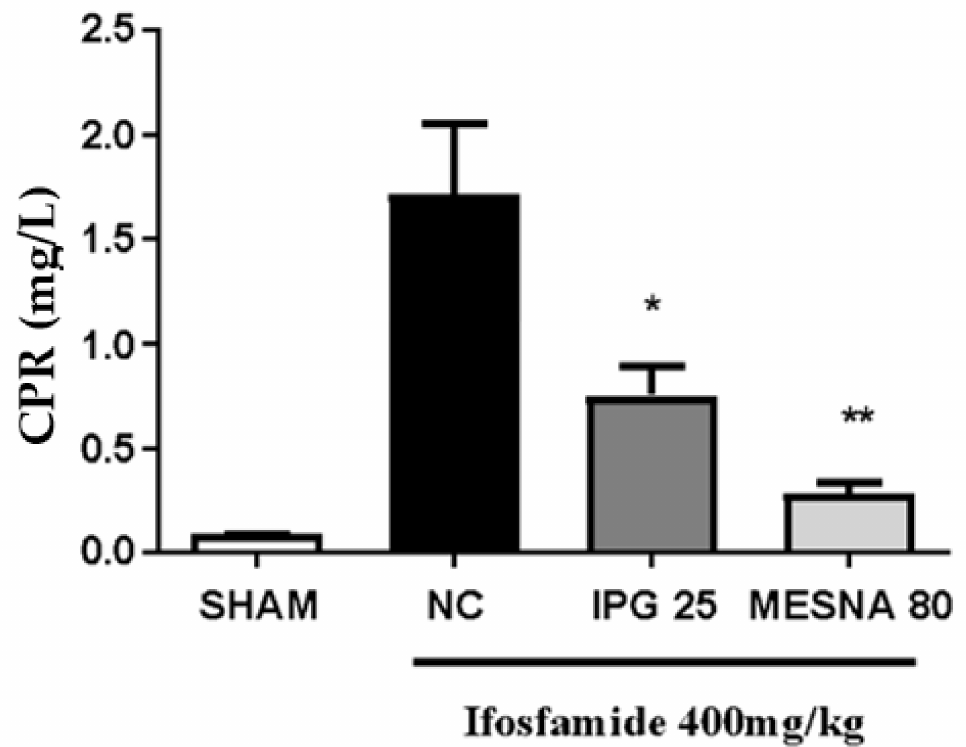
Figure 9. Effect of IPG on ultra-sensitive C-reactive protein (CRP) quantitatively determined in serum samples by immunoturbidimetry. Data are expressed in mg of CRP per liter of serum, as mean ± SEM ( n = 6). Data were compared with the negative control (NC, Tween/saline) by one-way analysis of variance (ANOVA), followed by the Bonferroni test; * p < 0.05, ** p <